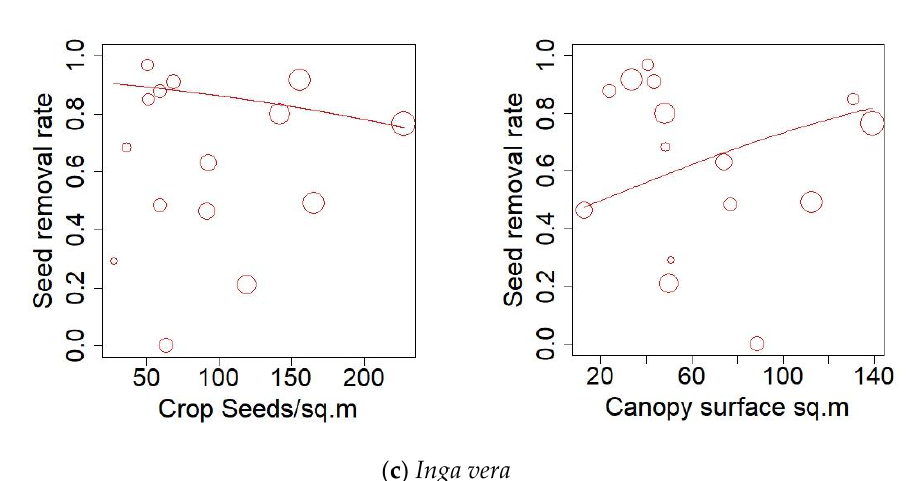
Figure 4. Results of the logistic regression models. ( a ) Seed removal rates as a function of forest cover around forest remnants ( H. tomentosa : Observed values in black squares and black prediction line, forest cover estimated in a landscapes of 1600 m radius, I. vera : Observed values in red circles and red dashed prediction line, forest cover estimated in landscapes of 1400 m radius); ( b , c ) seed removal rate as a function of crop size, and canopy surface (symbol size is a log function of total number of seeds taken into account for each